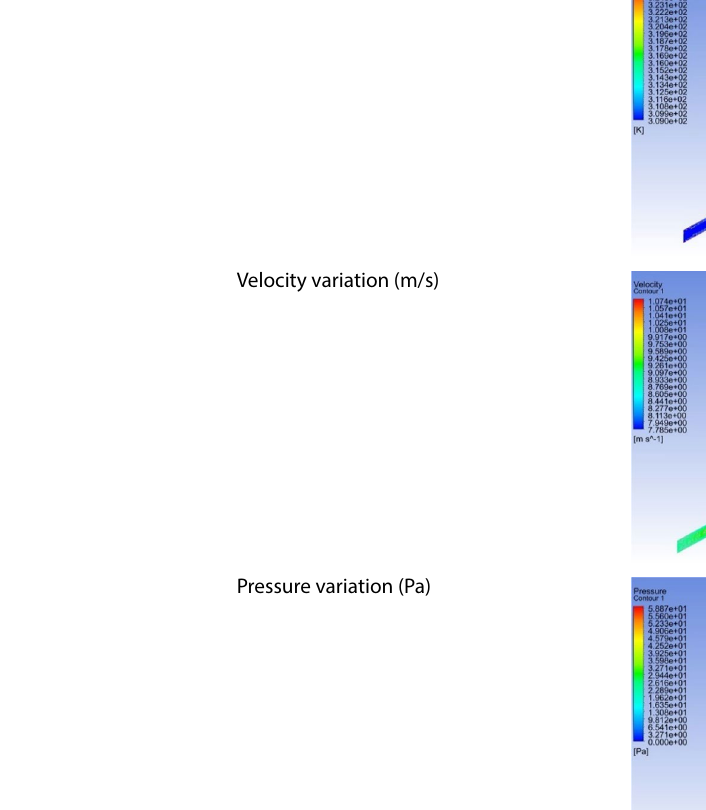
Table 2 Results of CFD analysis for fluid flow and heat transfer Test pipe without